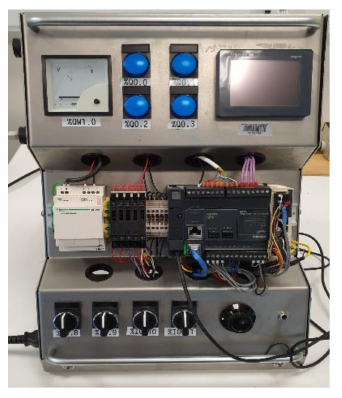
Figure 2. Schneider TM221CE24T PLC module.